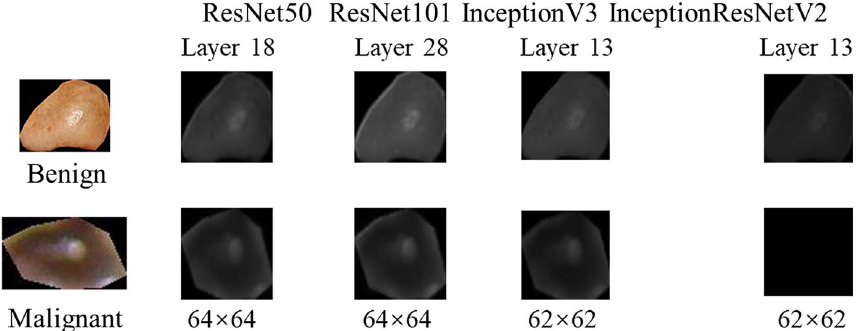
Fig. 6 The feature maps in four types of